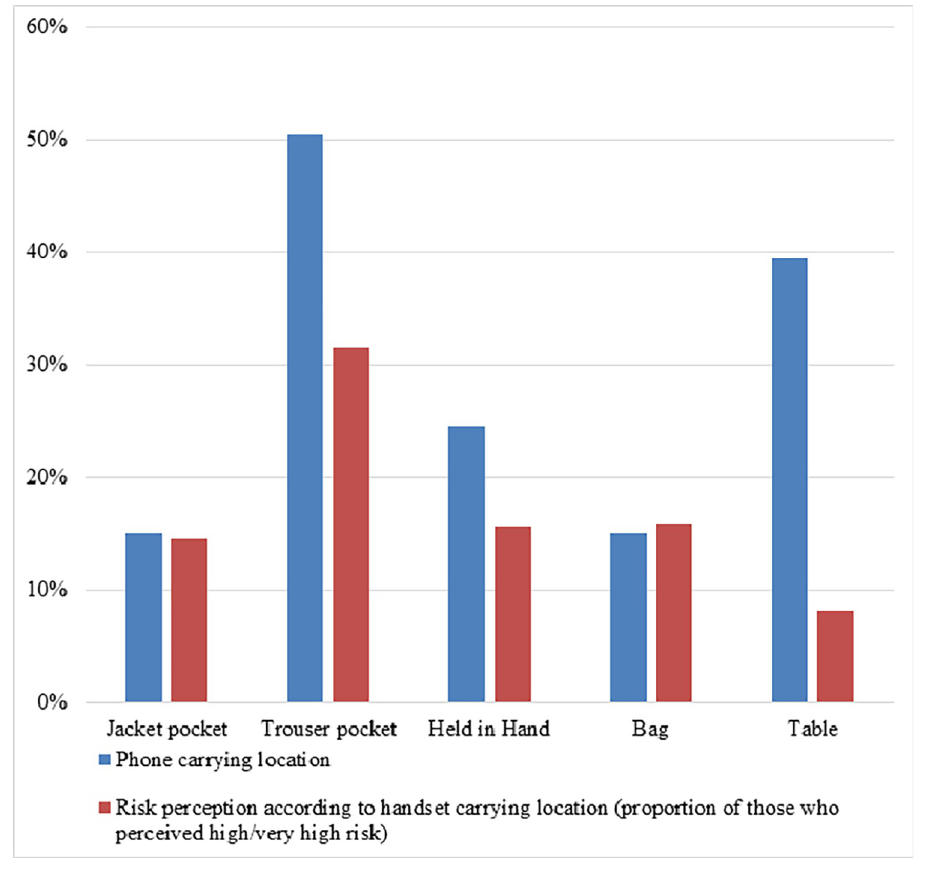
Fig 3. Mobile phone carrying locations and risk perception of